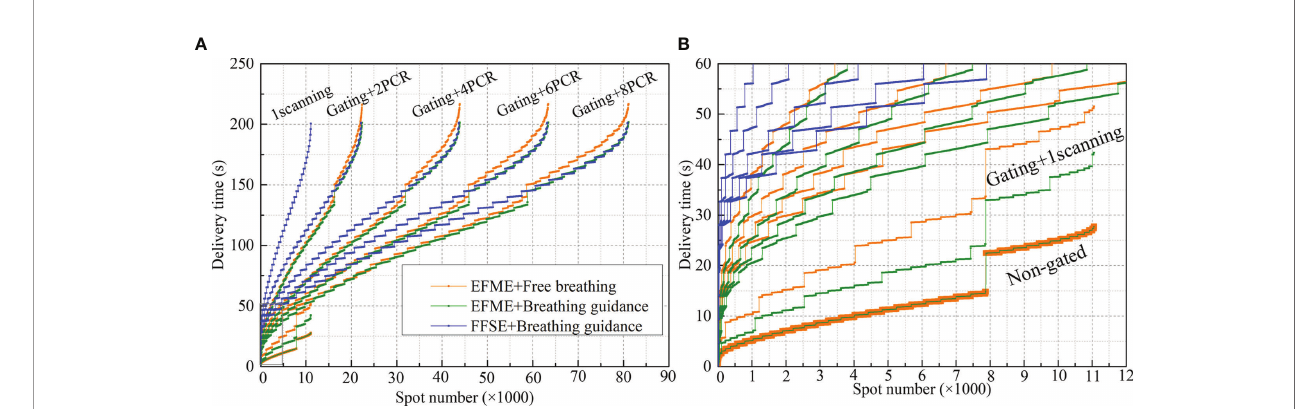
FIGURE 3 | Beam delivery time sequences offree-breathing and breathing guidance plans under different motion mitigation scenarios (non-gated, gating + 1 scanning, gating + phase-controlled rescanning (PCR)) delivered in the extended fl attop with multi-energy (EFME) and fi xed fl attop with single-energy (FFSE) synchrotron operation modes. Global graph with all the delivered spots (A) and partially enlarged graph (B) show